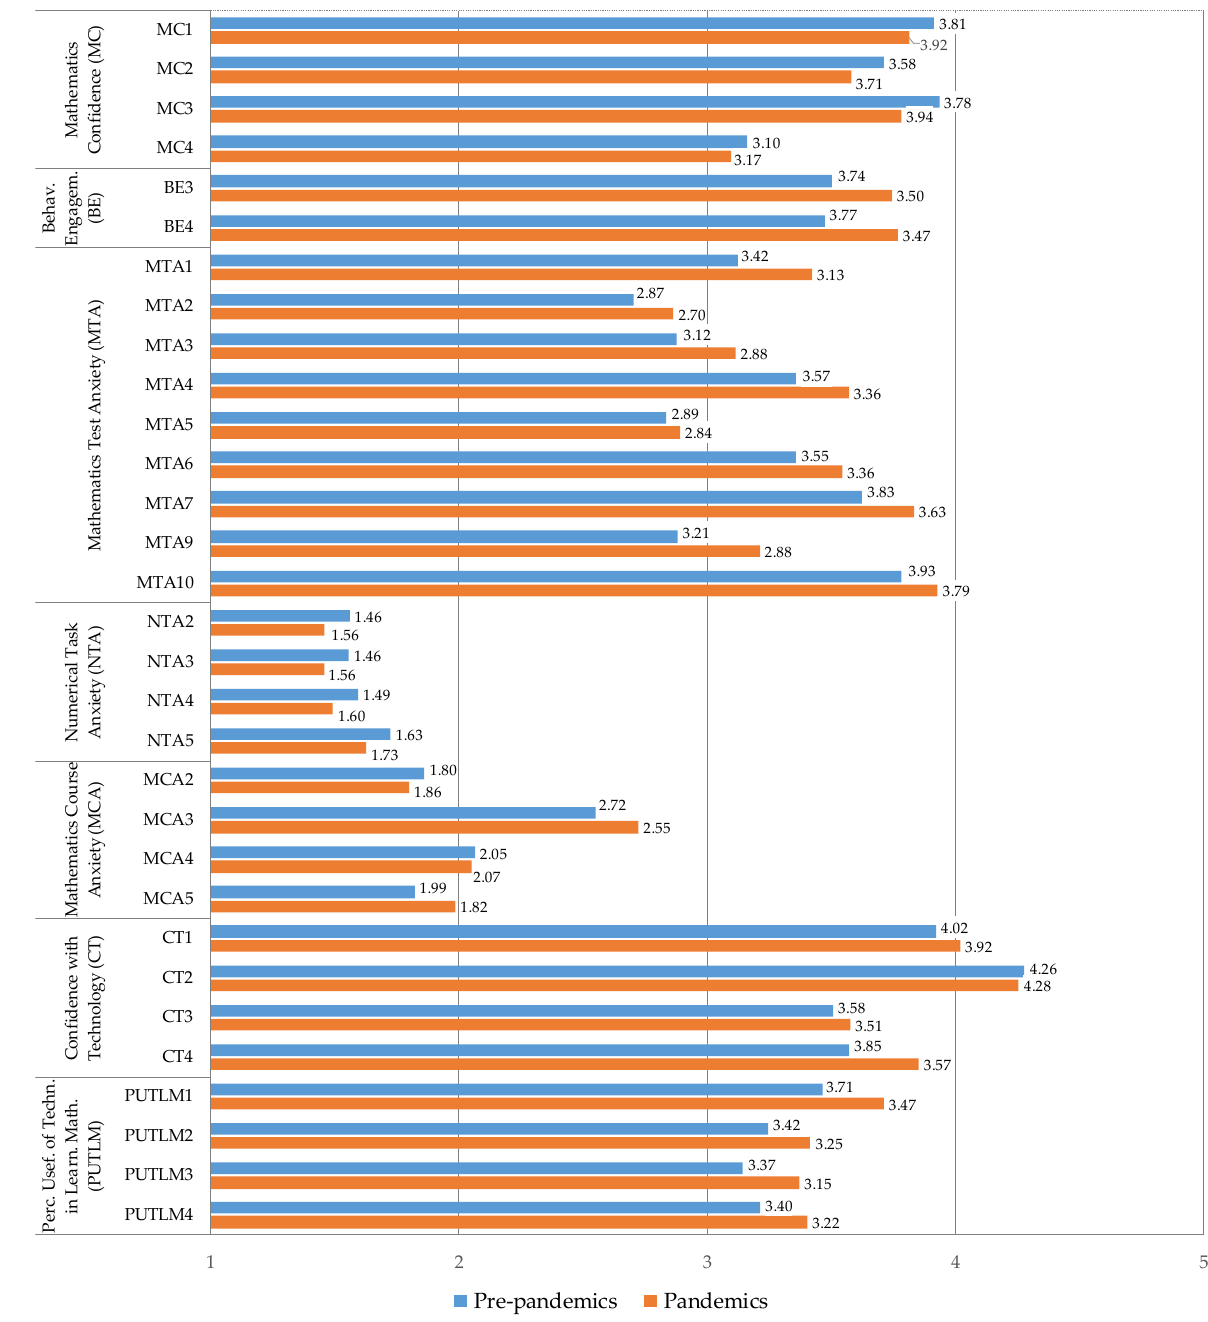
Figure 4. Mean values of questionnaire items measured on 5-point Likert-type scale. Table 4. Results of overall fit of measurement